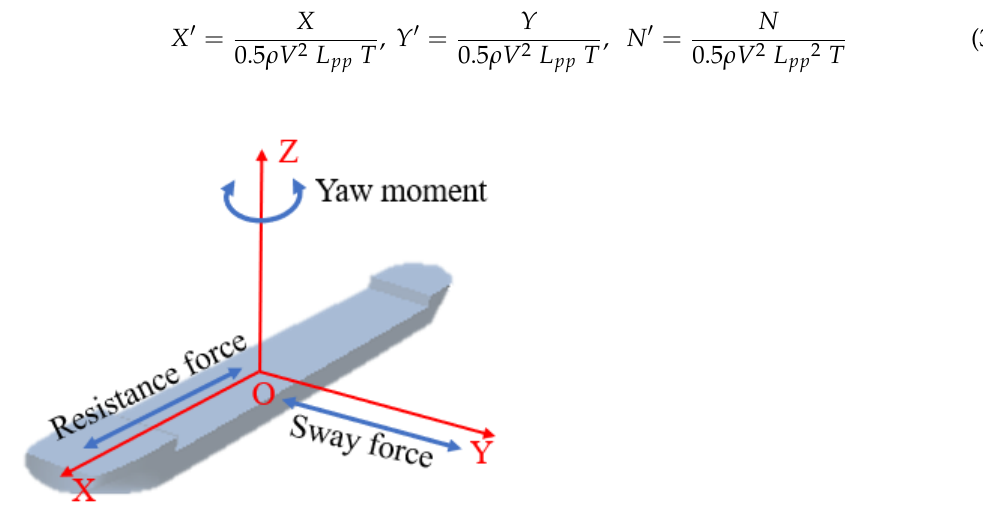
Figure 3. Motion illustrations of the ship model in this work.